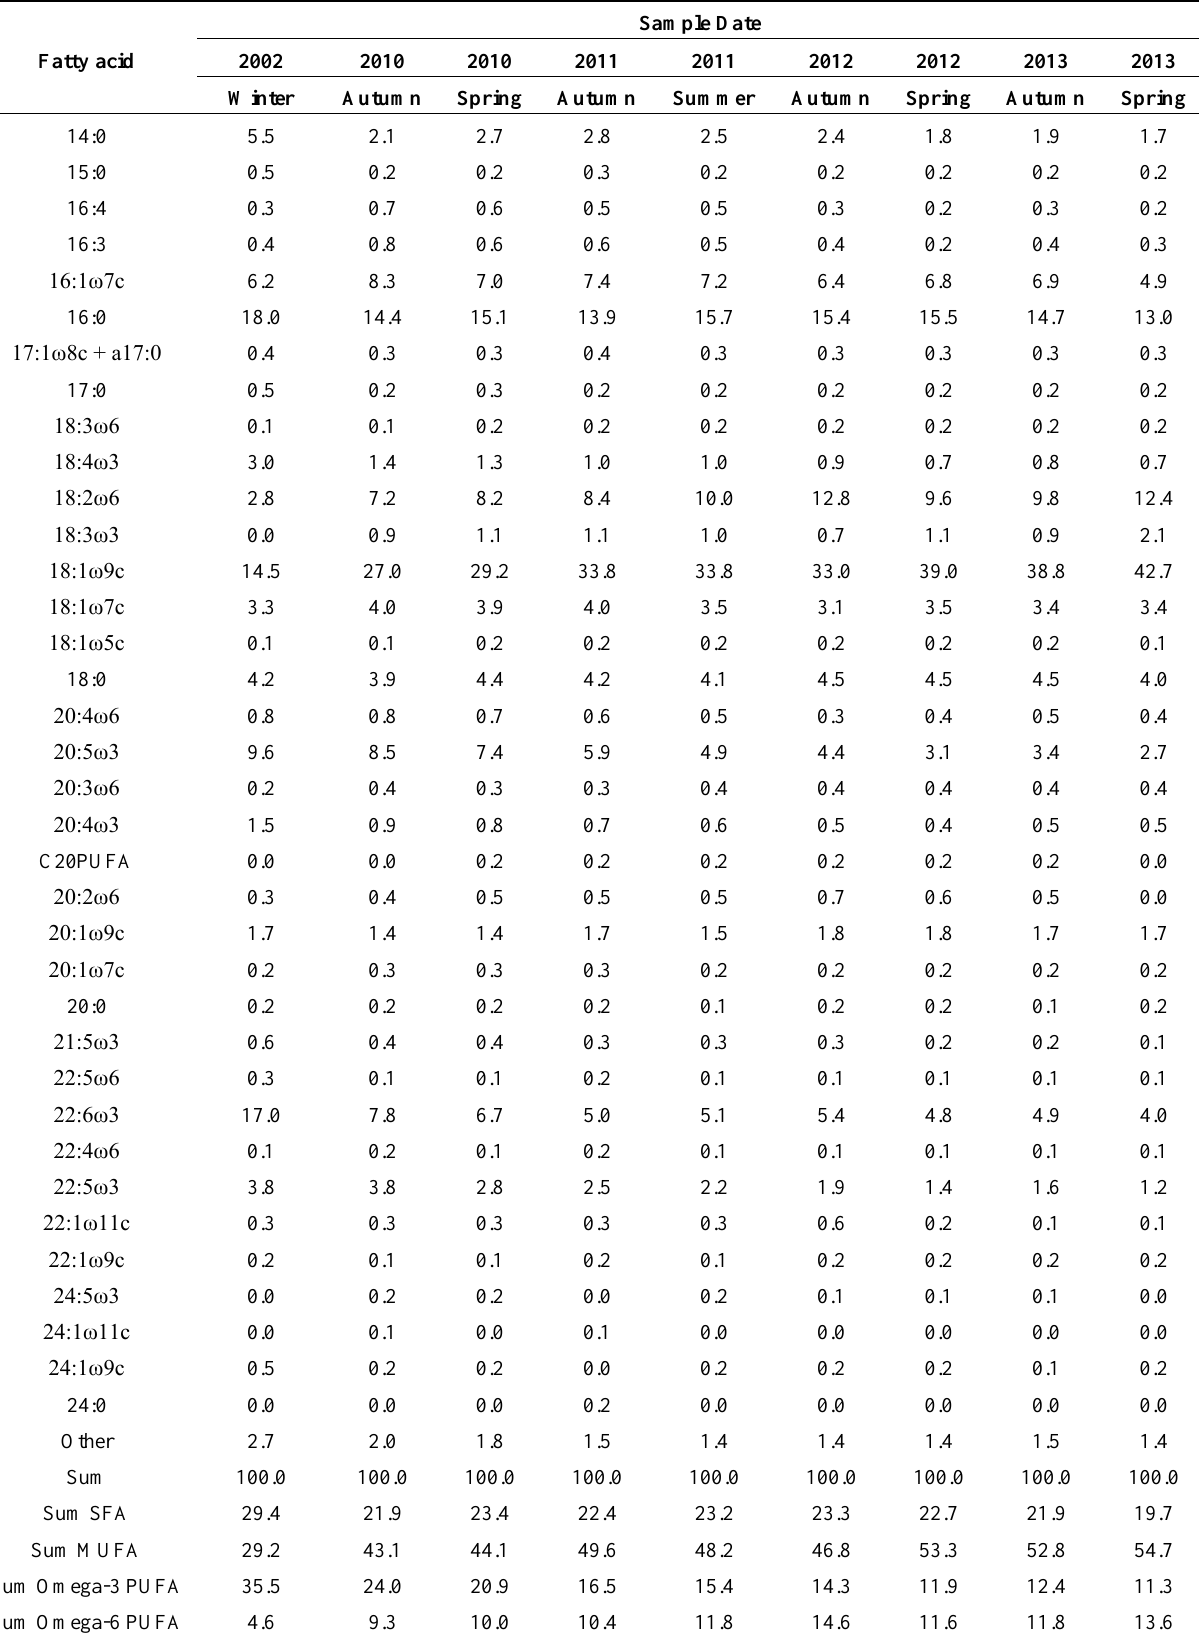
Table 1. Composition of fatty acids (as percent of total FA) in farmed Atlantic salmon ( n = 3)—2002 and